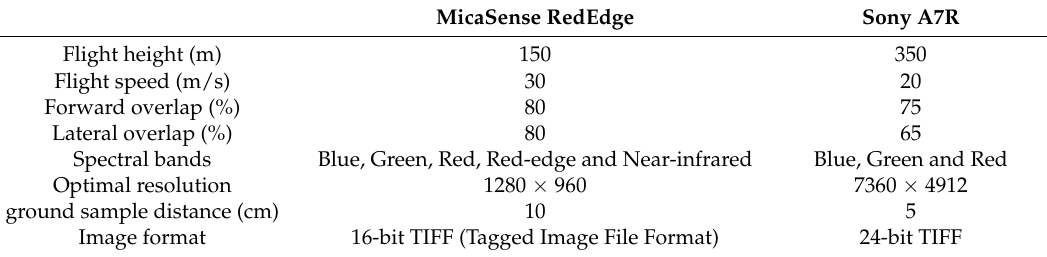
Table 2. Imagery acquisition